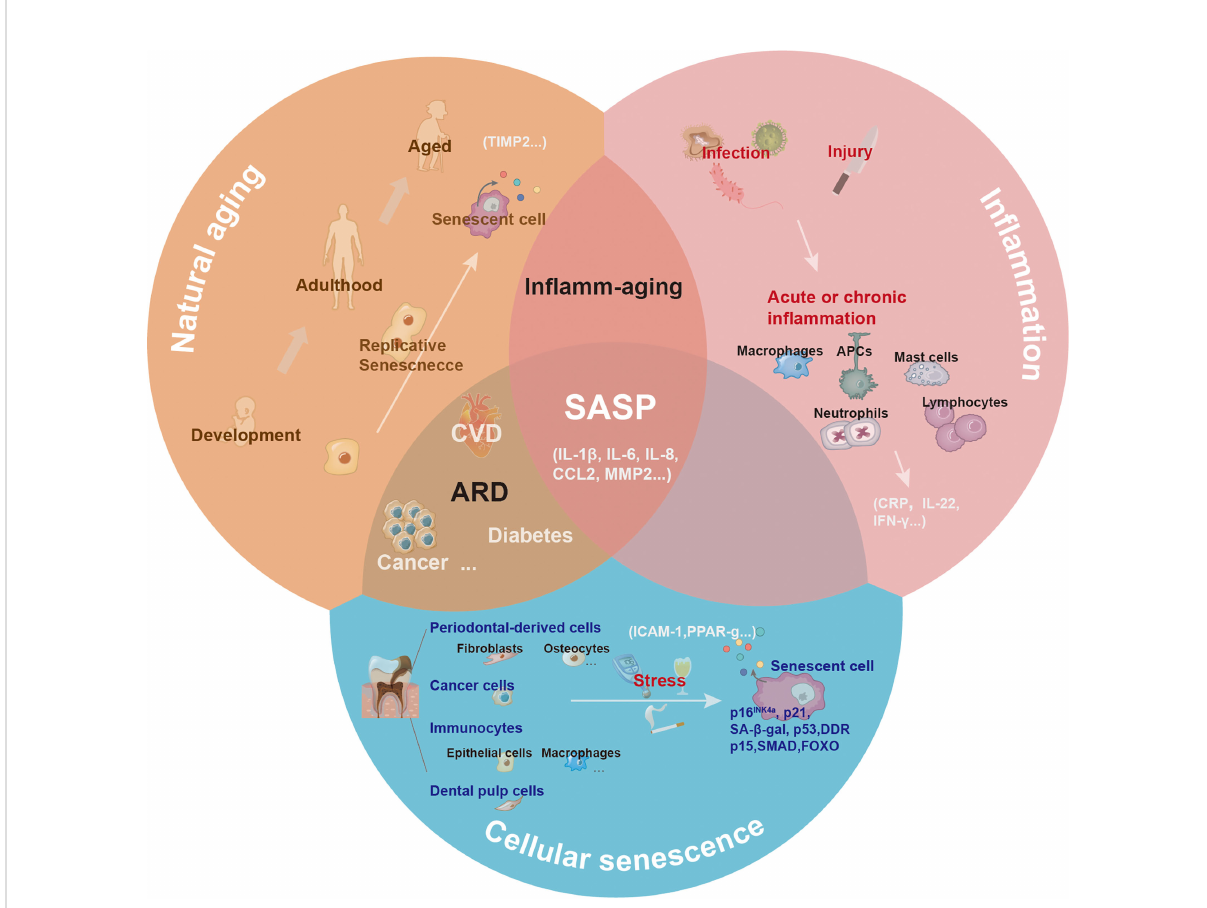
FIGURE 4 The central role of senescence-associated secretory phenotype in natural aging, in fl ammation, and cellular senescence. With natural aging, there is a progressive loss in tissue and organ functions, and accumulated senescence-associated secretory phenotype (SASP) can contribute to this process. Depending on the triggers, including infection or injury, the in fl ammatory response has different pathological consequences. The in fl ammatory response can be ampli fi ed via the secretion of in fl ammatory cytokines. Various cells (such as epithelial cells, dental pulp cells, fi broblasts, and macrophages) in the oral cavity undergoing senescence release SASP to the local microenvironment under the induction of natural aging and